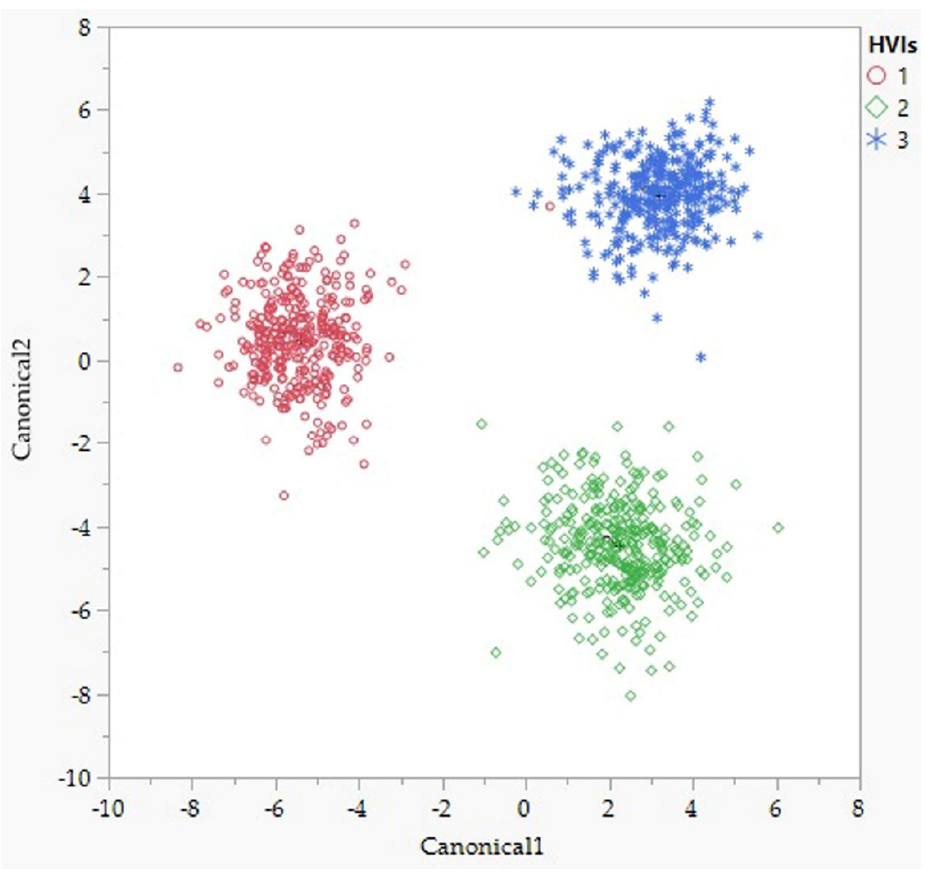
Figure 8. Linear discriminant analysis (LDA) to model the variance of the fibrogram across the high volume instruments.